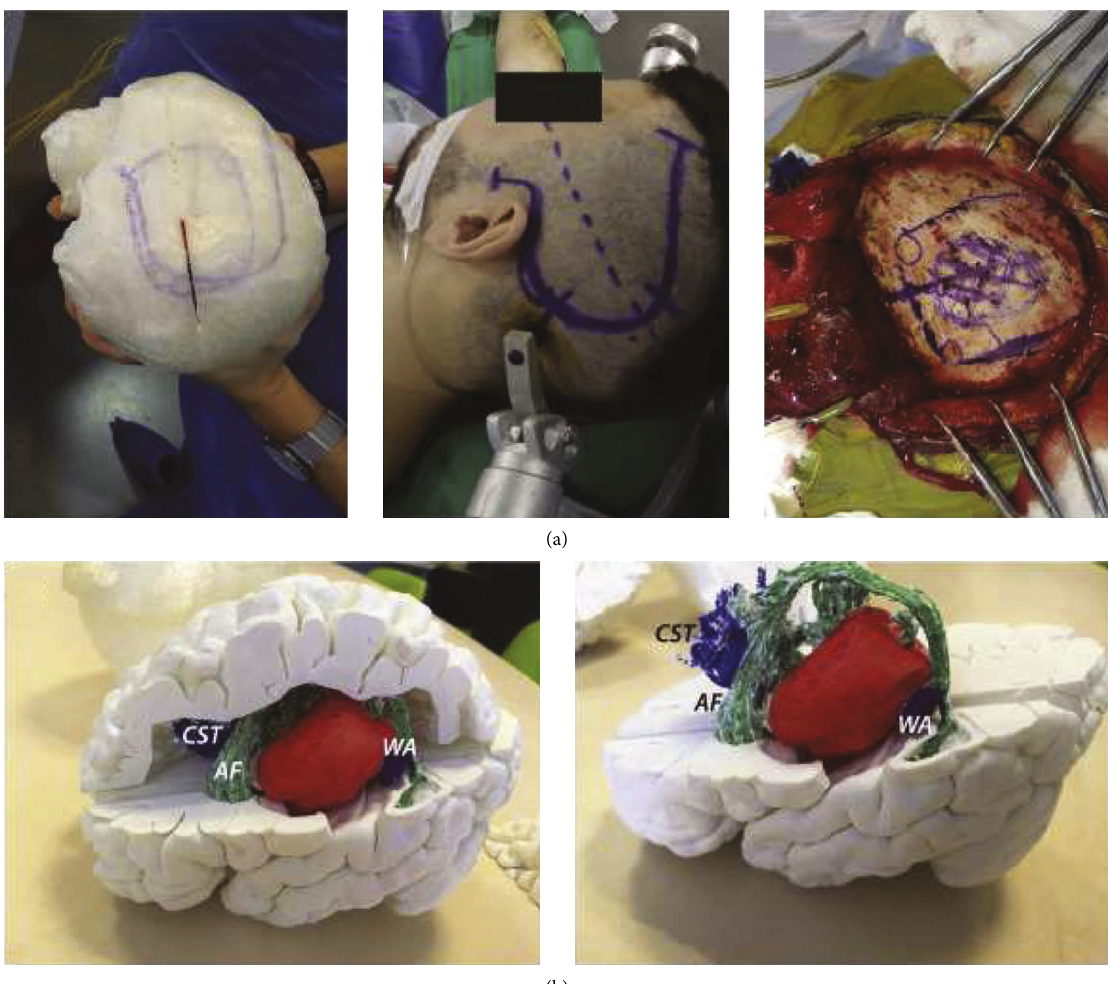
Figure 8: Three-dimensional (3D)-printed model. (a) The printed model of the skull was employed to plan the surgical approach for this patient. (b) 3D-printed model of the intracranial structures of interest: glioma (in red), the corticospinal tract (CST) (in blue), the arcuate fasciculus (AF) (in green), and Wernicke volume of activation (WA) (in purple); reproduced with permission by Gomez-Feria et al. [53] (copyright 2020, Elsevier